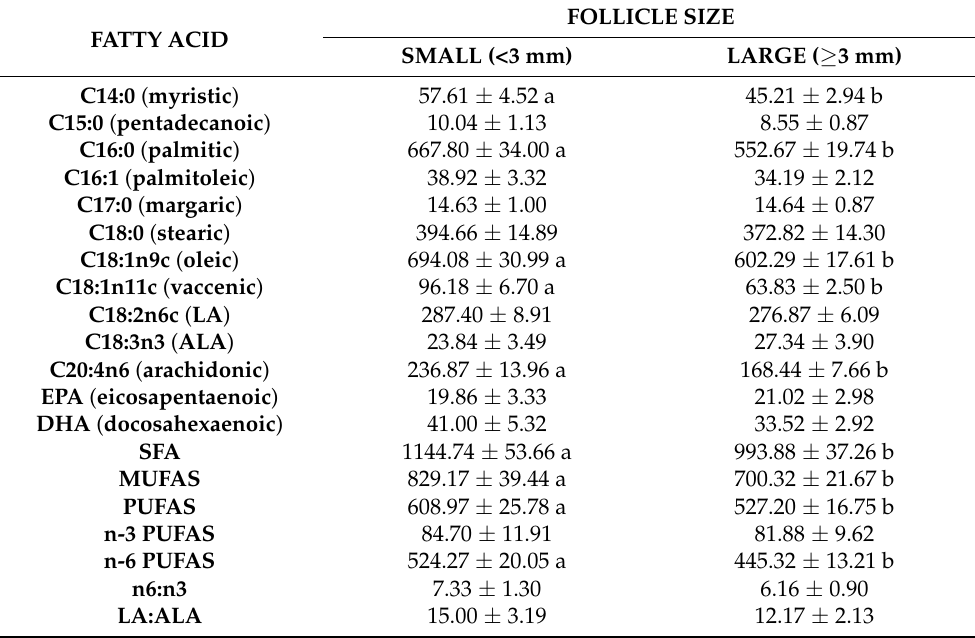
Table 2. Fatty Acid concentration ( µ M) in follicular fluid of 1 to 2-month-old suckling goats, according to the size of the